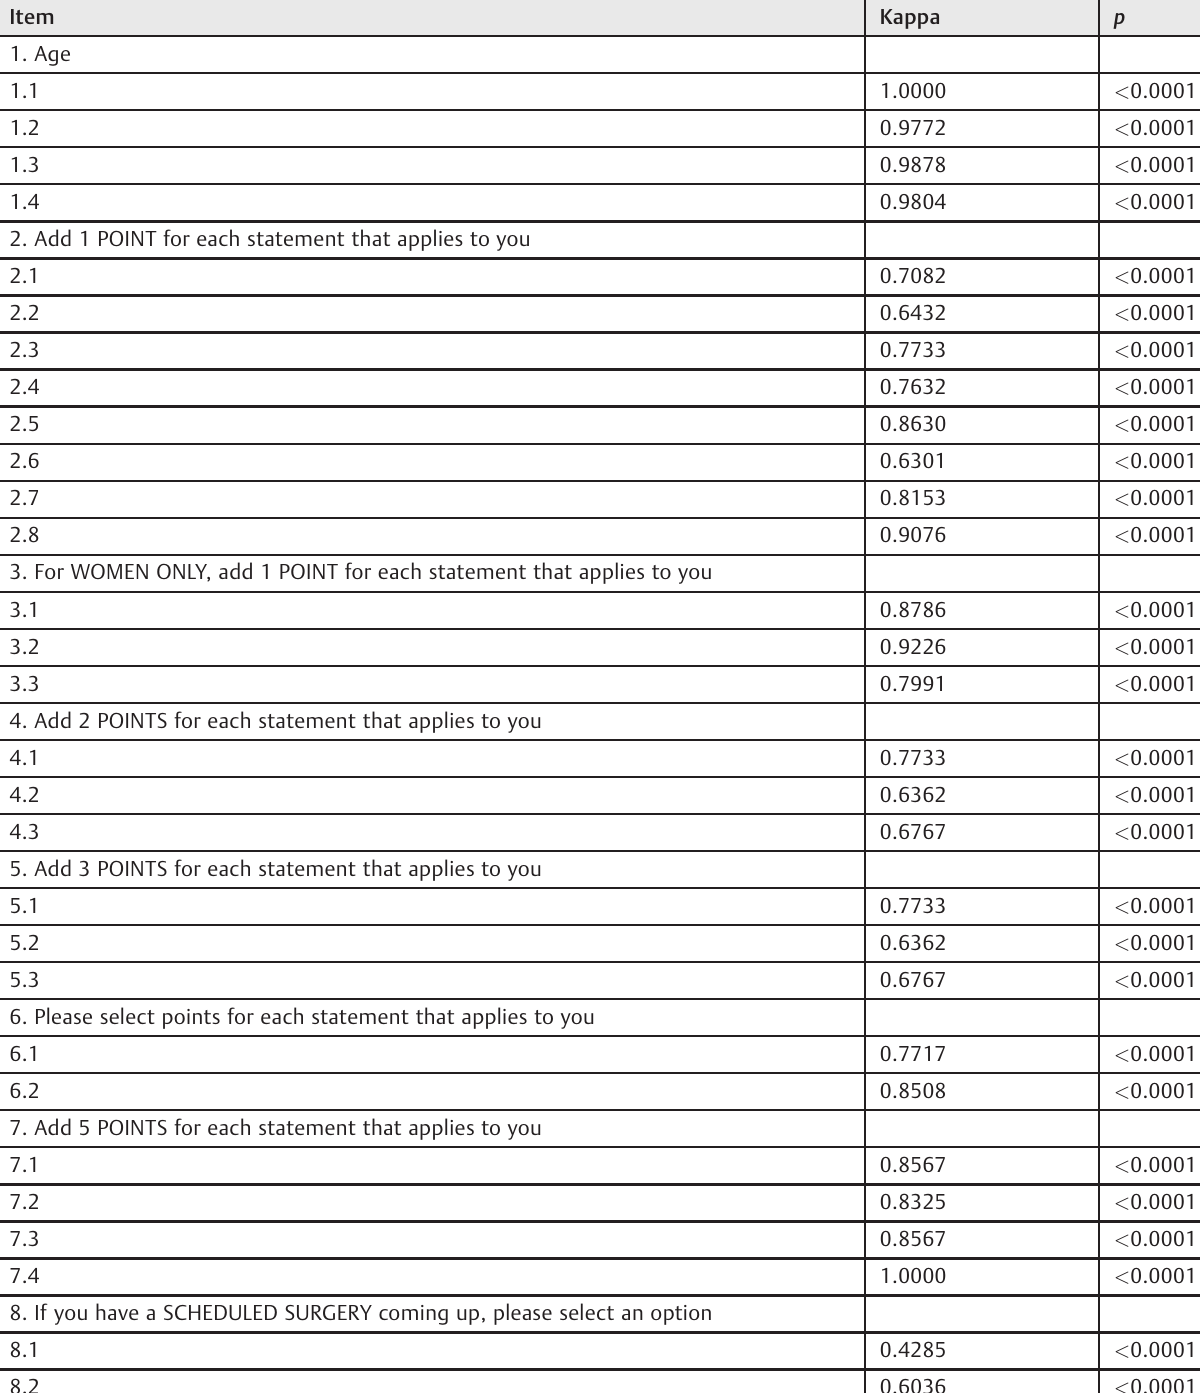
Table 3 Question-to-question agreement level between patient-completed and nurse-completed forms ( n ¼